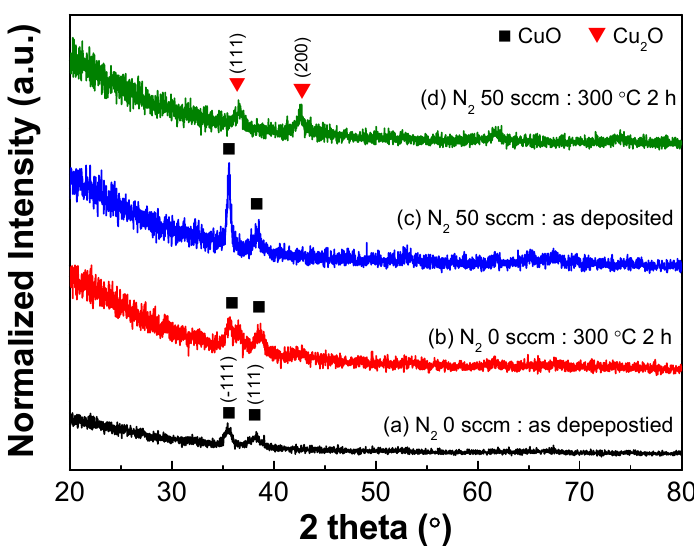
Figure 1. XRD patterns of Cu x O and CuON films. ( a ) as-deposited Cu x O, ( b ) annealed Cu x O, ( c ) as-deposited CuON, and ( d ) annealed CuON.